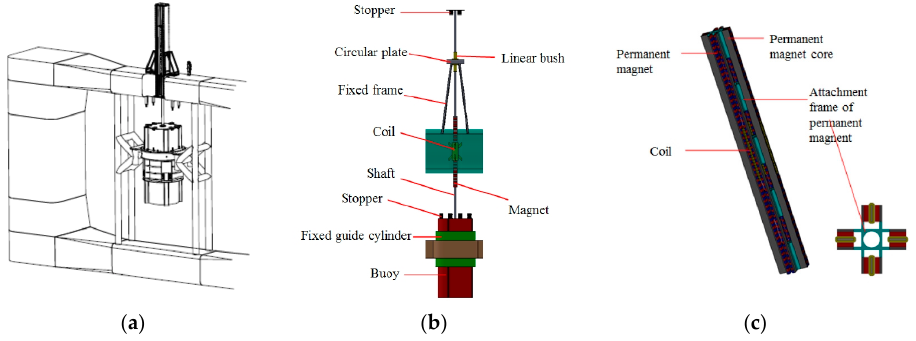
Figure 3. Details of wave energy converter [8,10]: ( a ) installed WEC system and support frame; ( b ) WEC system; ( c ) Linear generator.